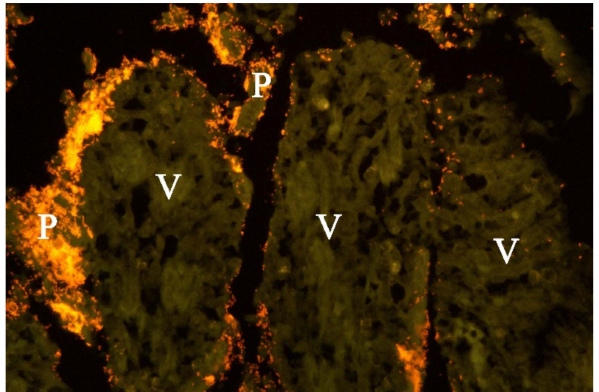
Figure 6. Histological section from small intestine of dog with acute haemorrhagic diarrhoea (a serial section to Figure 5. Providencia alicafaciens was visualised by in situ hybridization using a Cy3 labelled probe. The tissue is orange due to autofluorescence using a red–green double filter set. The Gram-negative bacteria shown in Figure 5 were identified as P. alcalifaciens (P). V =